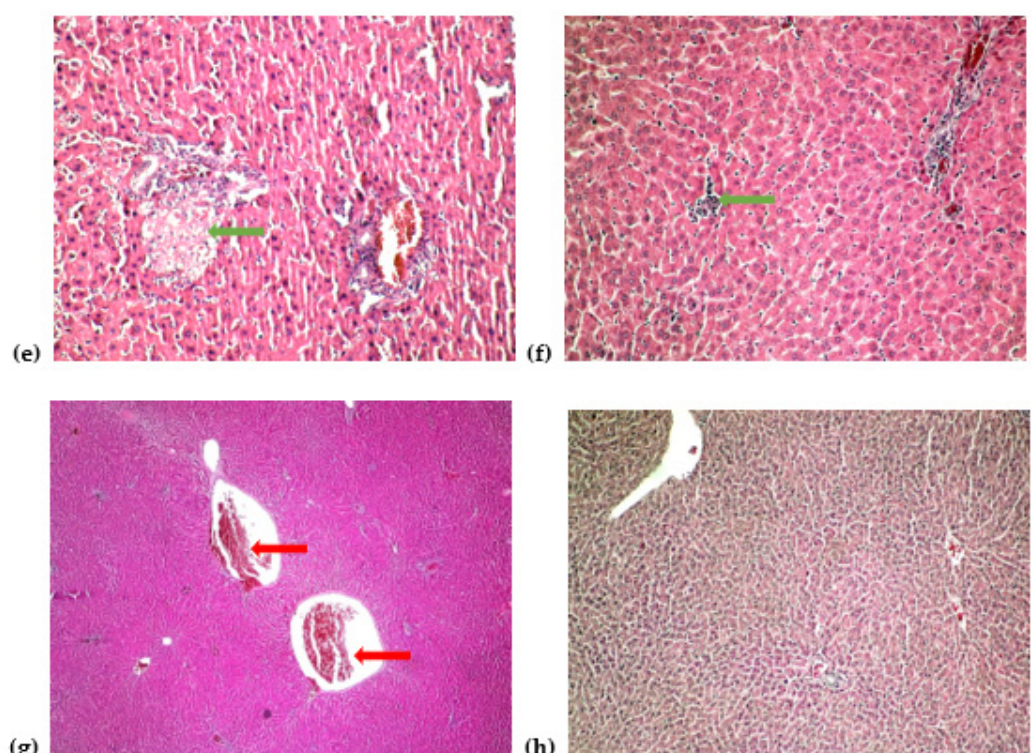
Figure 6. Histopathological examinations of the liver tissue. ( a ) C (normal architecture of the liver), ( b ) AMI (blood stasis with well recognizable integral erythrocytes in a congested blood vessel (red arrow)), ( c ) T1DM (multifocal micronecrosis (black arrow)), ( d ) T1DM-AMI (lobular micronecrosis (black arrow) and blood stasis (red arrow)), ( e ) S-T1DM-CC-AMI (focal necrosis (green arrow)), ( f ) CC-T1DM-CC-AMI (focal necrosis (green arrow)), ( g ) S-T1DM-NC-AMI (blood stasis with well recognizable integral erythrocytes in a congested blood vessel (red arrow)), ( h ) NC-T1DM-NC-AMI (normal architecture of the liver).